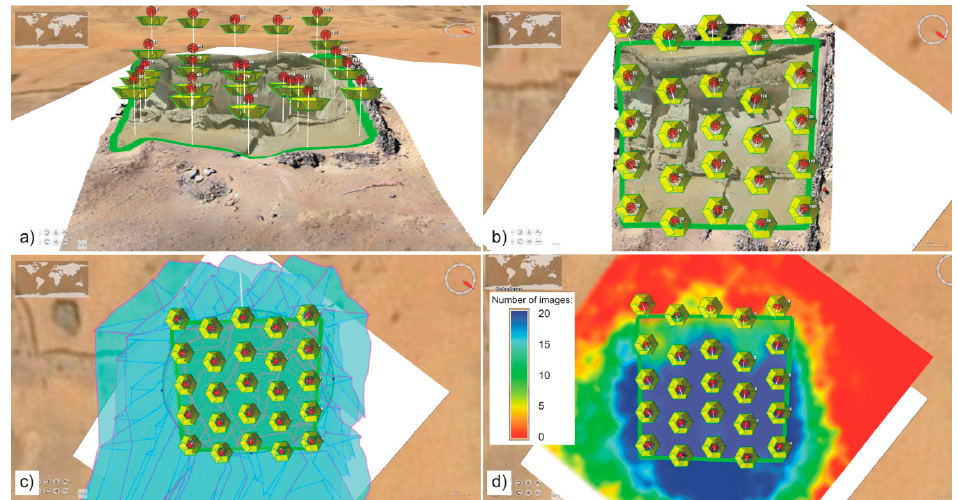
Figure 12. Mission planning of terrestrial photogrammetry using mast: ( a ) and ( b ) image locations (lateral and top views, respectively), ( c ) footprint map, and ( d ) images coverage map.